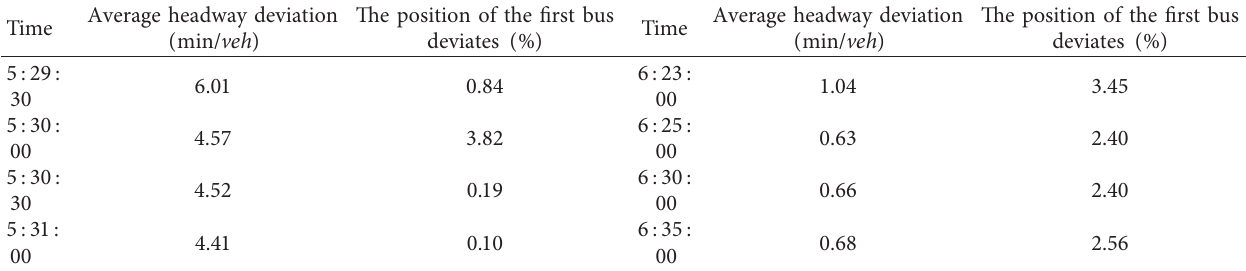
Table 4: Simulation output results under the control strategy of the full-length bus